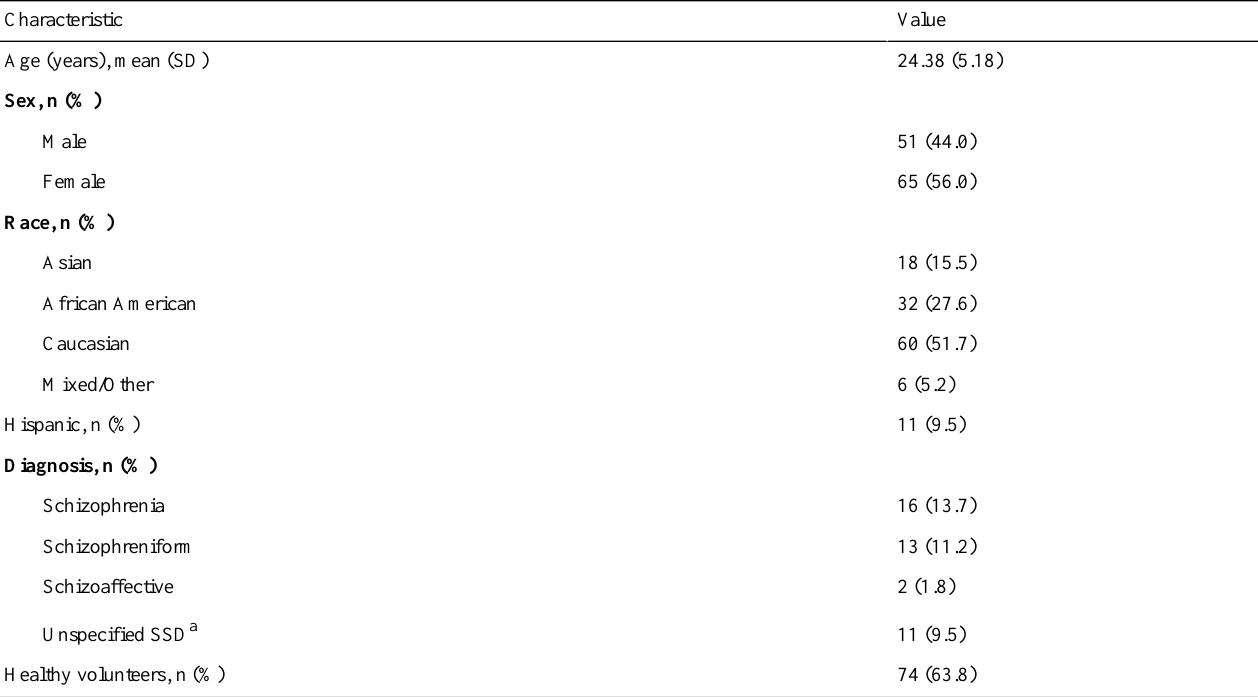
Table 2. Participant demographics (N=116).